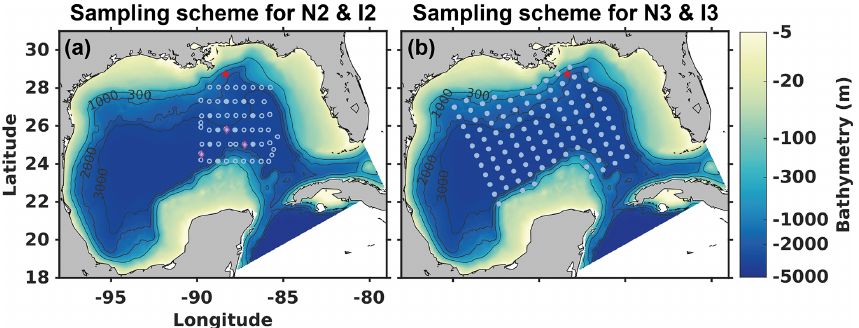
Figure 1. Model domain and bathymetry. The red star denotes the location of the DwH oil rig. (a) Sampling scheme for twin experiments N2 and I2. The symbols represent stations where temperature (circles) and salinity (magenta diamonds) profiles were collected by Shay et al. (2011), with deep temperature or salinity profiles (down to 1000m) marked as filled circles or magenta diamonds and shallow temperature profiles (down to 400m) as open circles. (b) Sampling scheme for N3 and I3. The dots represent stations where temperature and salinity profiles extending to 1000m of depth were sampled from the “truth”